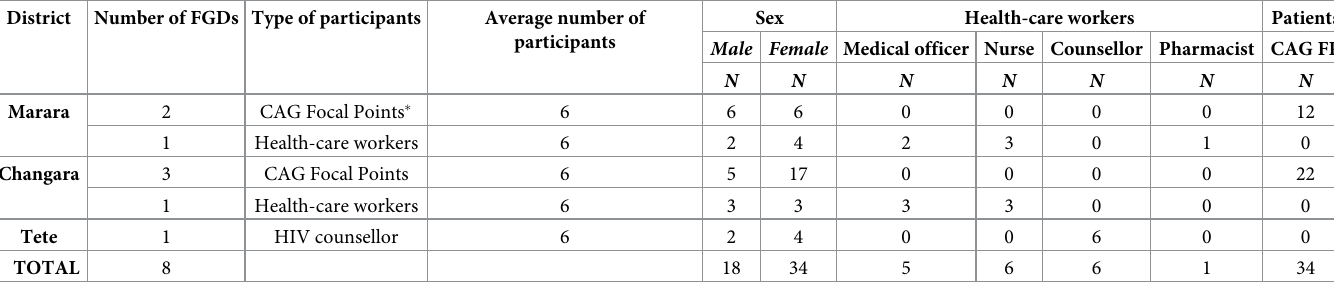
Table 2. Characteristics of Focus Group Discussion participants. District Number of FGDs Type of